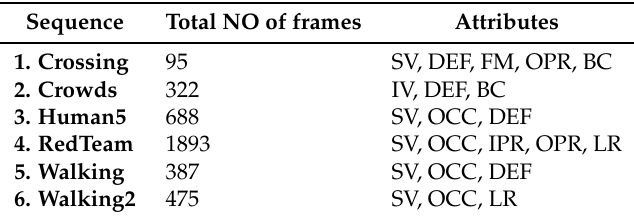
Table 8. Example of Online tracking benchmark video